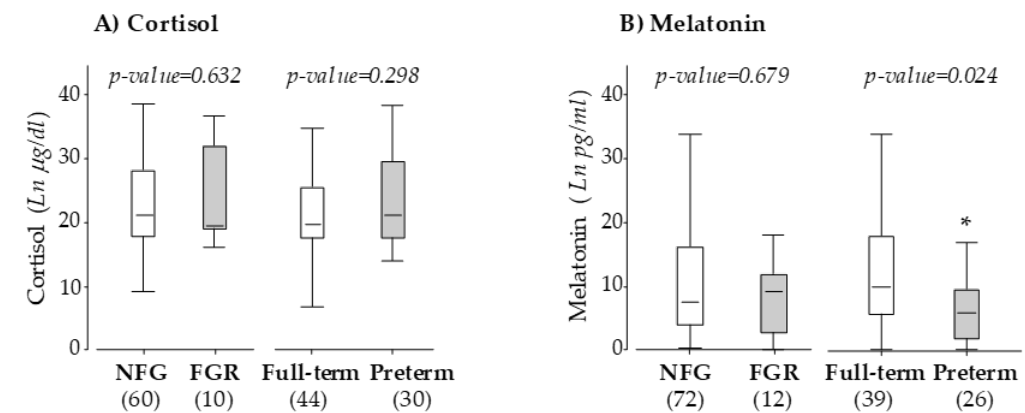
Figure 3. Maternal plasma cortisol ( A ) and melatonin ( B ) at 10 weeks of gestation. Data compare pregnant women with normal fetal growth (NFG) versus fetal growth restriction (FGR) and women with full-term versus preterm labor. Graphs show the median and IQR. Sample size is shown between brackets; * p < 0.05, U Mann–Whitney test.